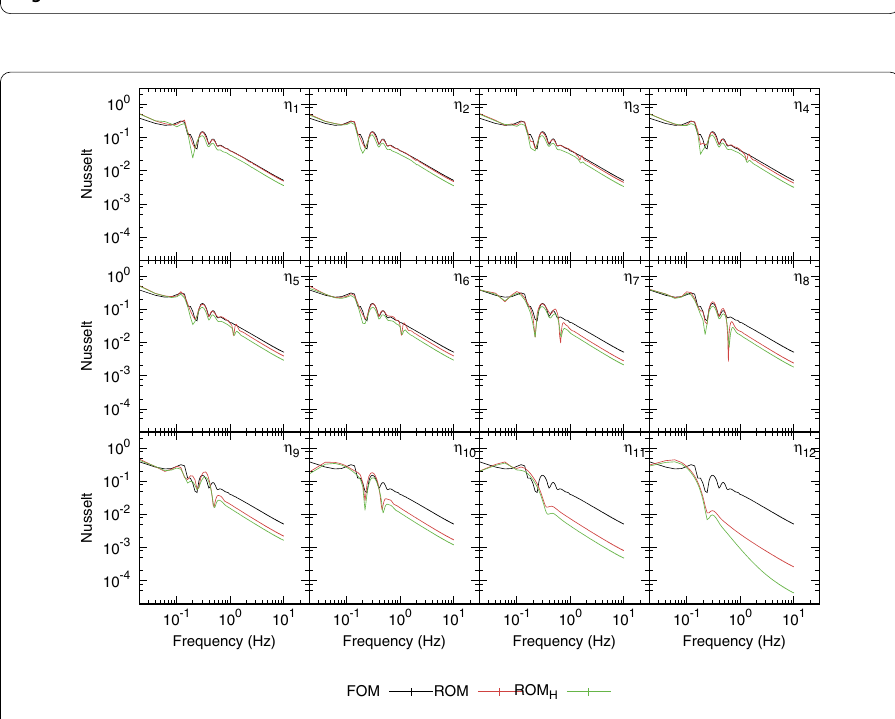
Fig. 9 Fourier transform of the Nusselt number for the cold wall